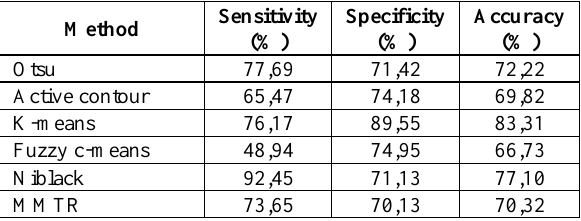
Table 1. Sensitivity, specificity and accuracy values of